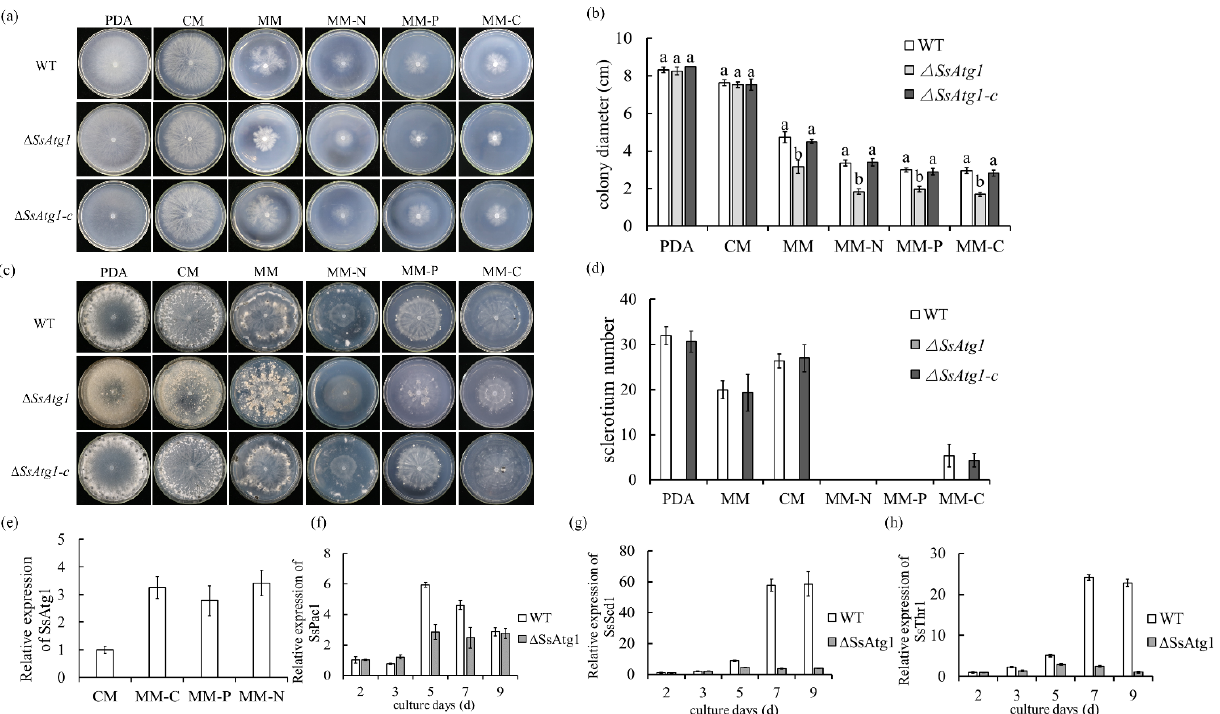
Figure 3. SsAtg1 is required for sclerotium formation. ( a , b ) Colony morphology and colony diameter of ∆ SsAtg1 and control strains. Strains were inoculated on PDA, CM, MM, MM-N, MM-C and MM-P and colony diameters were measured by the cross method at 48 h. Error bars represent the standard deviations and the letters indicated significant differences ( p < 0.05). ( c , d ) SsAtg1 mutation affected sclerotia development. Colony morphology and sclerotia number were recorded after four weeks. Error bars represent mean standard deviation, and statistical significance of data was analyzed using SPSS software ( p < 0.05). ( e ) The expression of SsAtg1 was significantly increased in nutrient deficient medium. ( f – h ) Deficiency of SsAtg1 affects the expression of key genes regulating sclerotia